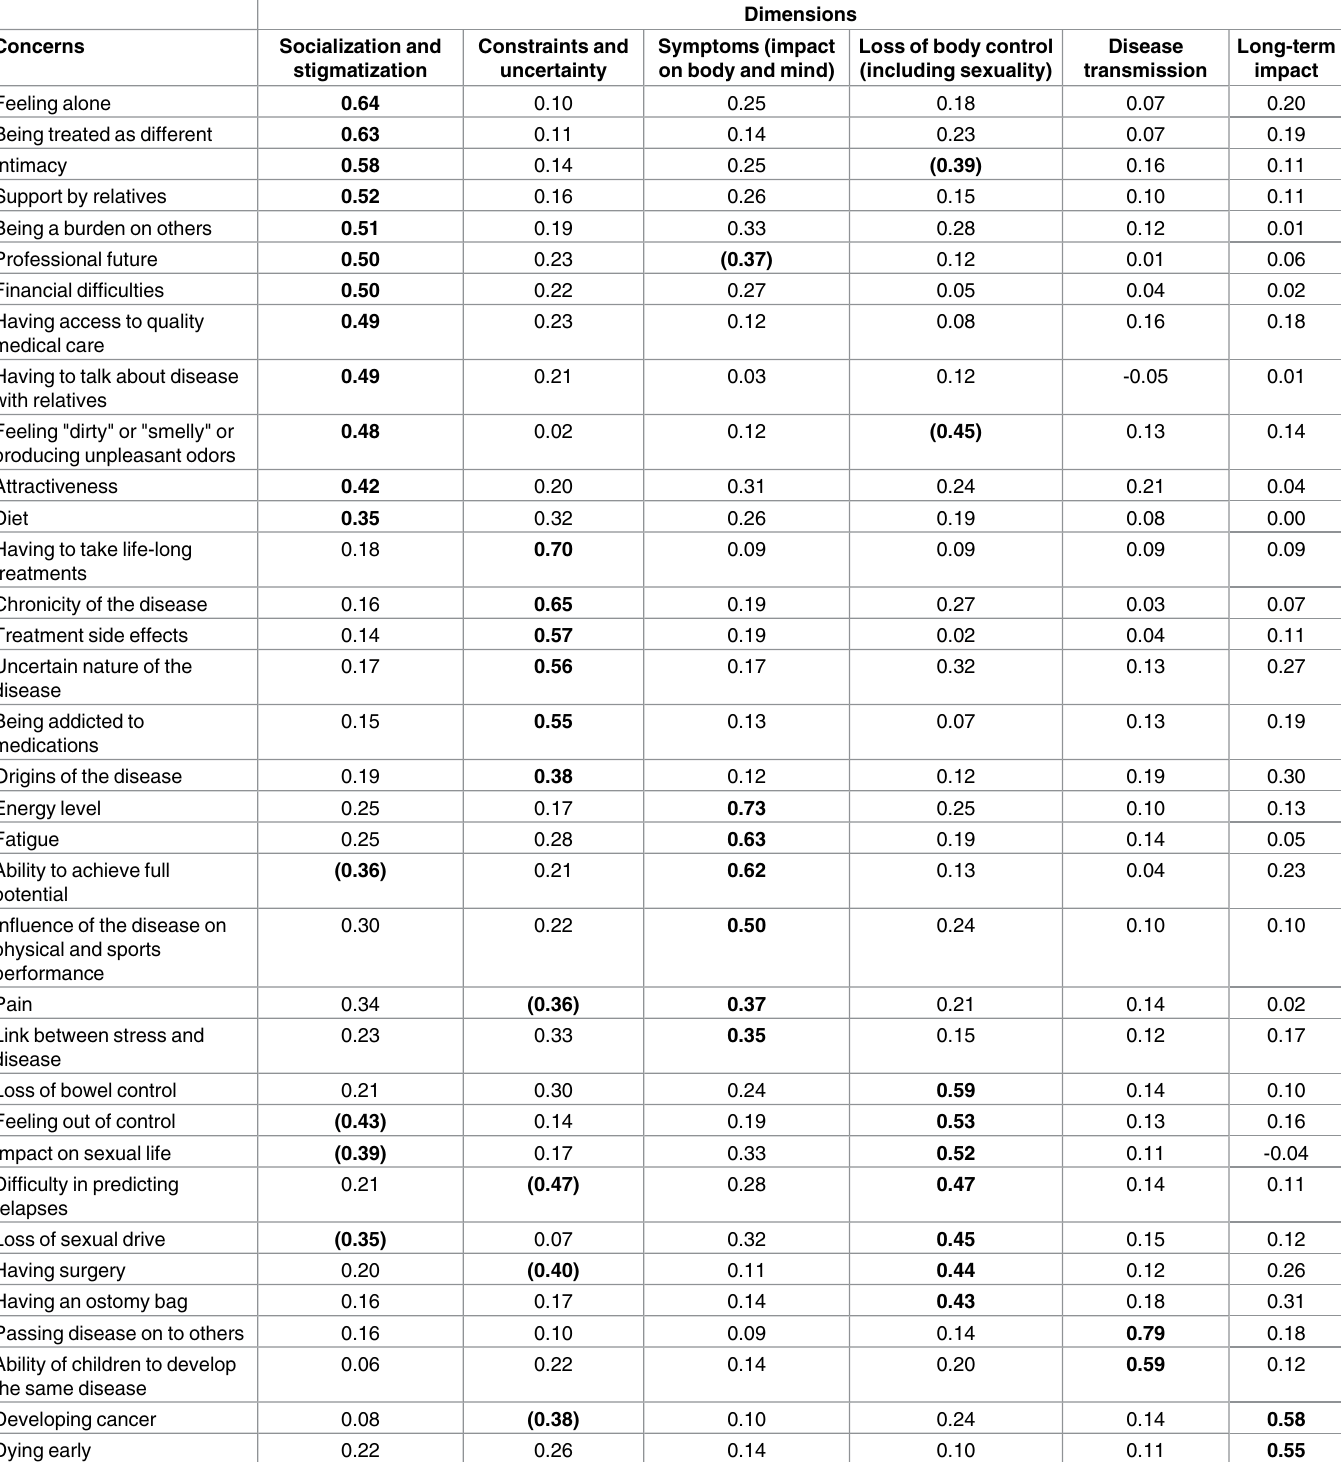
Table 3. Results of the rotated factor